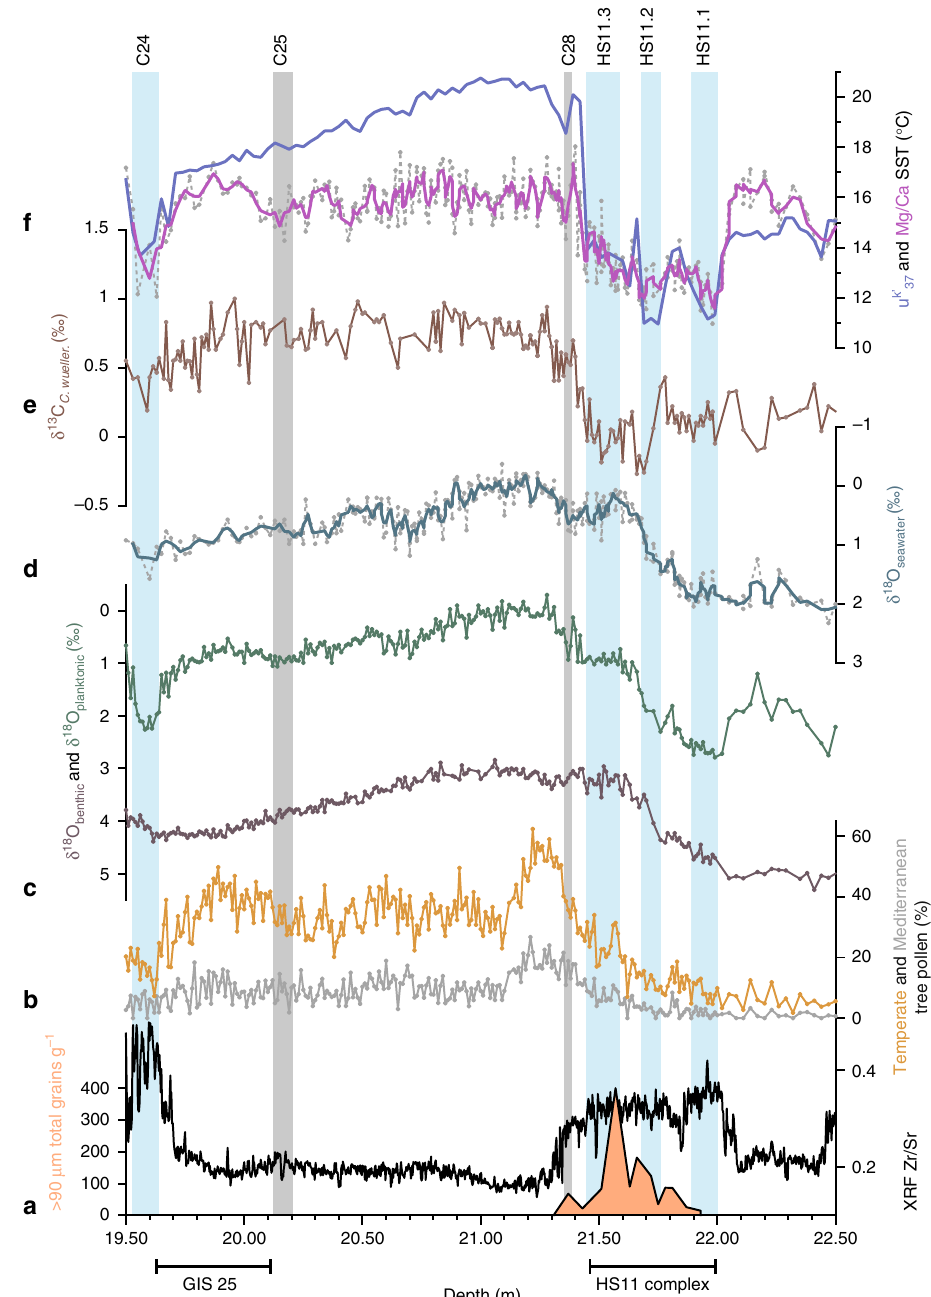
Fig. 1 MD01-2444 LIG records plotted against depth. a XRF Zr/Sr record; ice-rafted detritus (IRD) counts for the interval 21.3 – 21.95 m only 25 . b Mediterranean and temperate (Mediterranean + Eurosiberian) tree pollen percentages (see Methods). c Planktonic ( G. bulloides ) and benthic foraminiferal δ 18 O. d Seawater δ 18 O, derived from G. bulloides δ 18 O and Mg/Ca SST. e δ 13 C of epibenthic species C. wuellerstor fi . f Alkenone-based u k ′ 37 (ref. 24 ) and G. bulloides Mg/Ca SST. Vertical bars indicate events HS11.1, HS11.2, HS11.3, C28, C25 and